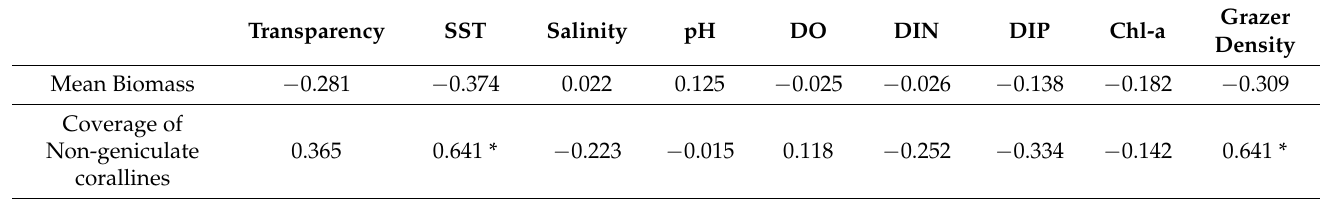
Table 5. Results of Pearson’s correlation analysis for marine environment and seaweed